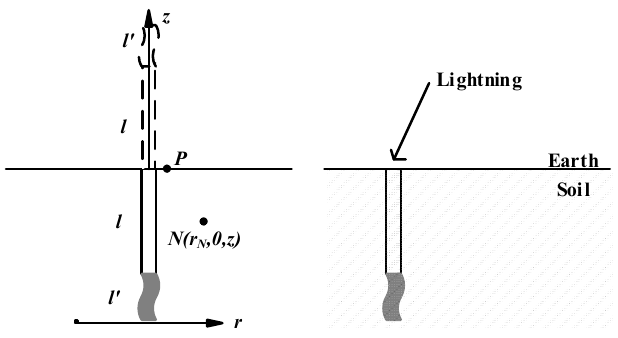
Figure 1. A round rod-shaped ground electrode embedded in the ground vertically.